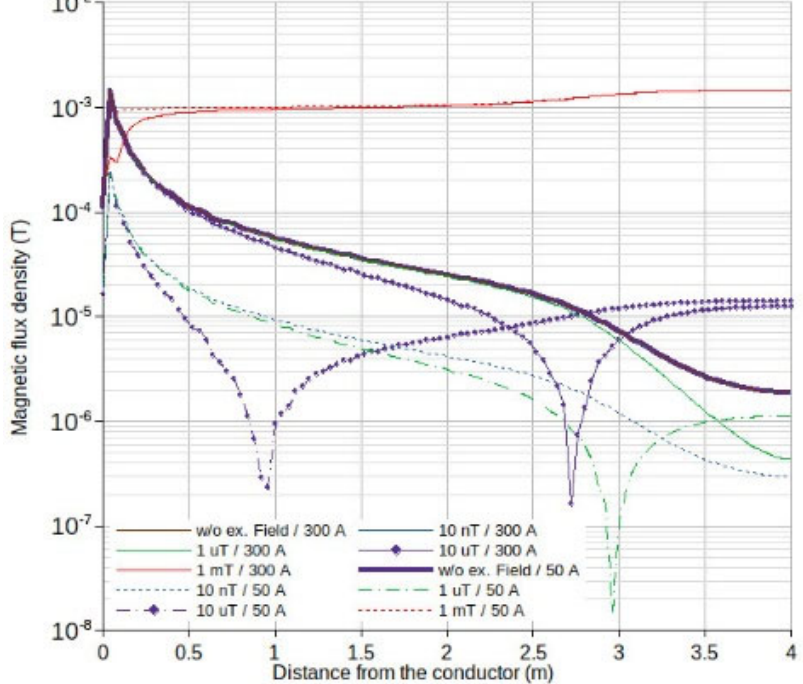
Figure 2. Location of the control line in the computational domain.